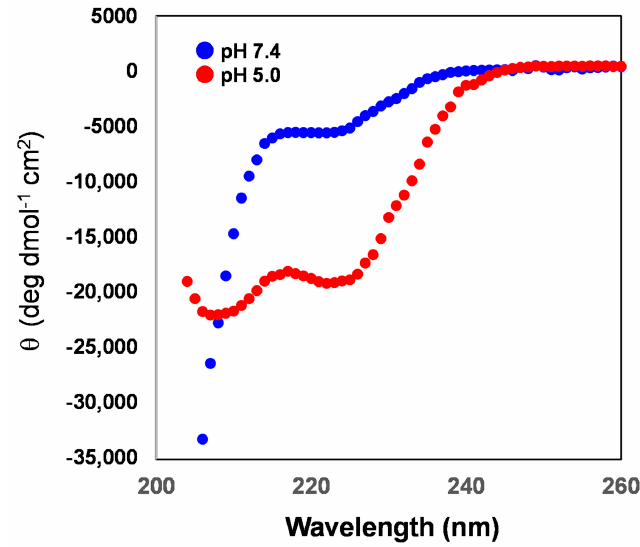
Figure 8. Circular dichroism (CD) spectra of the rLPE-St (1.0 mol%) anchored into the liposomal membranes at pH 7.4 and pH 5.0. Measurements were carried out at 25 ◦ C.